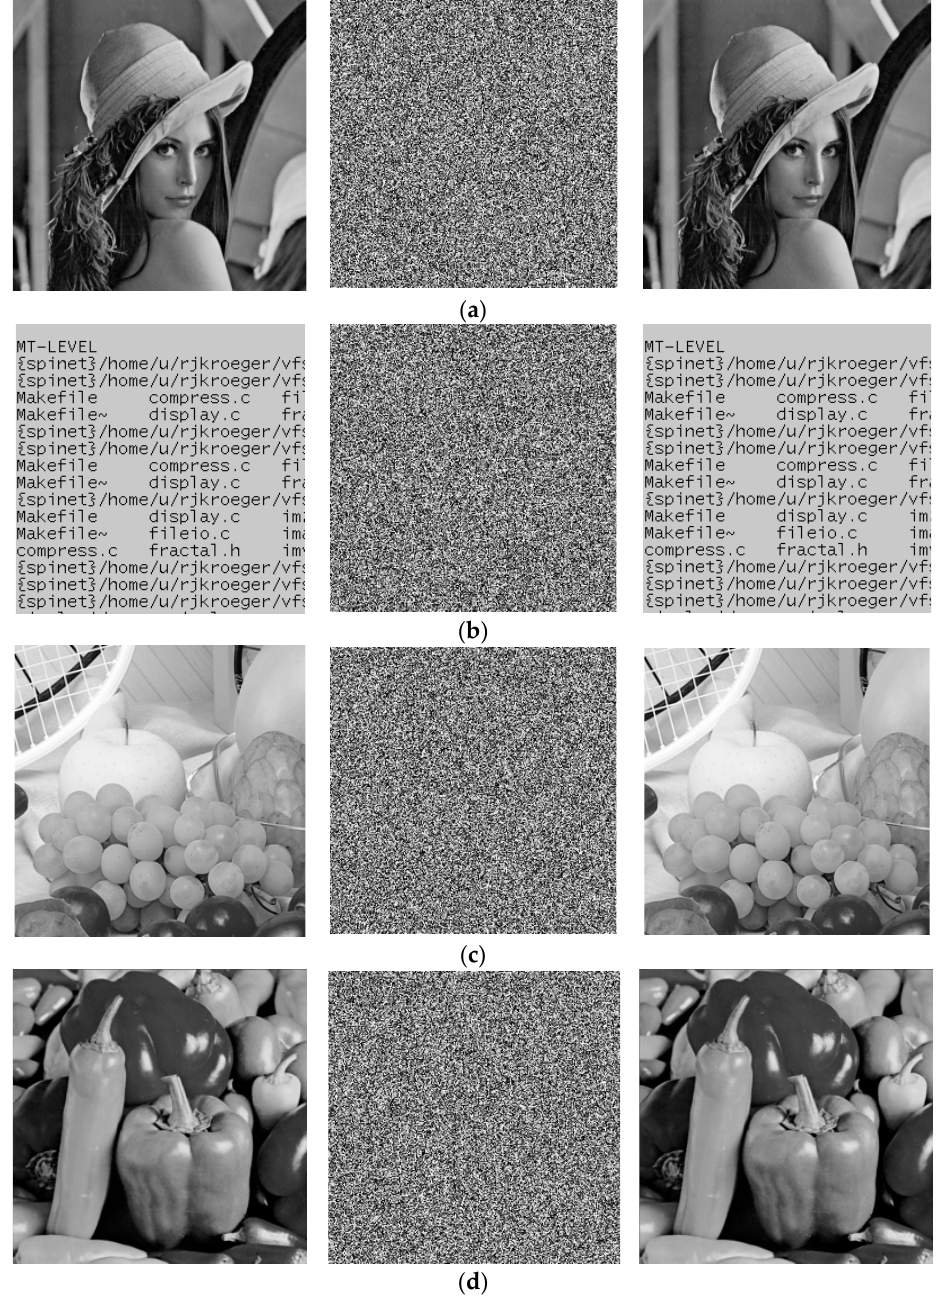
Figure 7. Image encryption and decryption results: ( a ) plain, cipher, and decrypted image of Lena; ( b ) plain, cipher, and decrypted image of text; ( c ) plain, cipher, and decrypted image of fruits; ( d ) plain, cipher, and decrypted image of peppers.